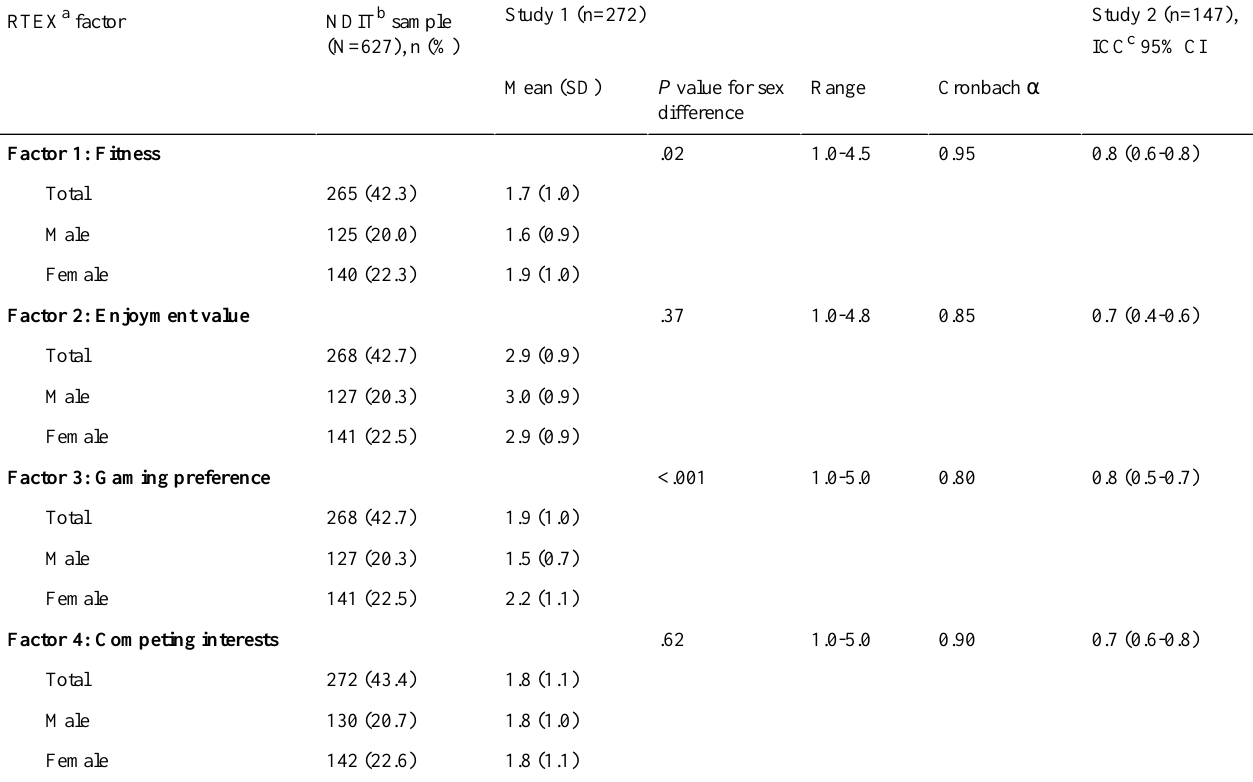
Table 3. Scores by sex and internal reliability coefficient (Cronbach α ) of RTEX factors (Study 1, 2017-2019) and intraclass correlation coefficient for test-retest reliability of RTEX factors (Study 2,